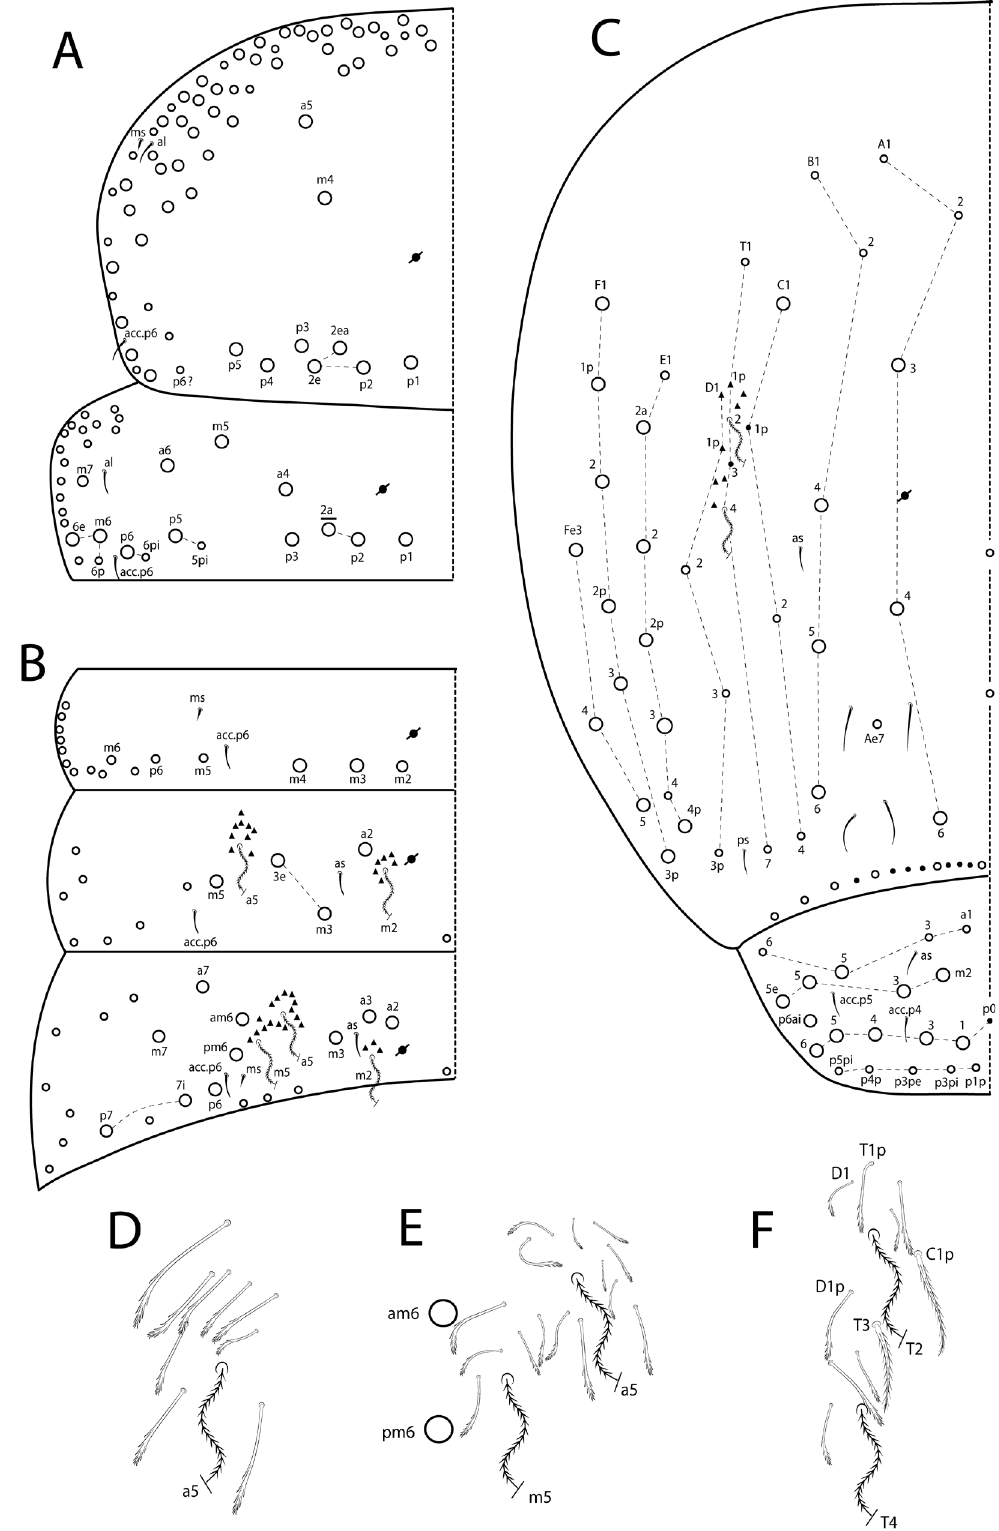
Fig. 6. Willowsia nigromaculata (Lubbock, 1873), dorsal chaetotaxy (left side). A . Th II–III. B . Abd I–III. C . Abd IV–V. D – F . Bothriotrichal complex. D . Abd II. E . Abd III. F . Abd IV. Abbreviations: see Material and